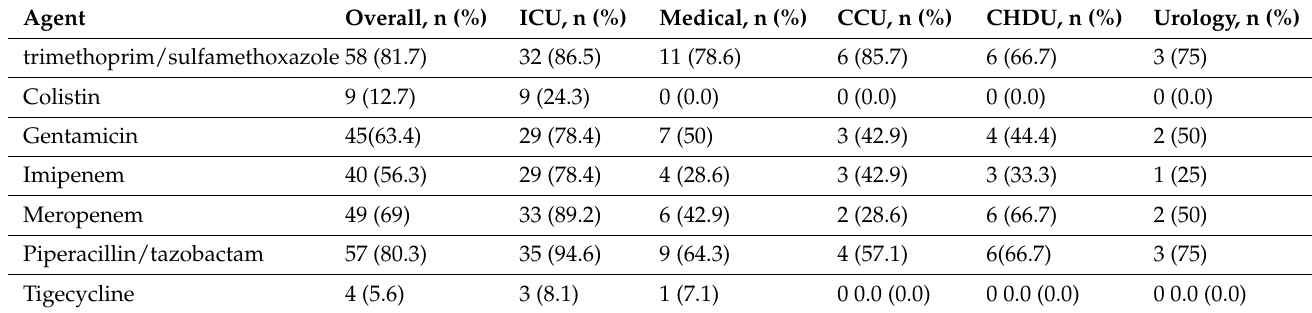
Figure 2. Distribution of carbapenemase-producing MDR. Klebsiella pneumoniae based on the types of clinical specimens.